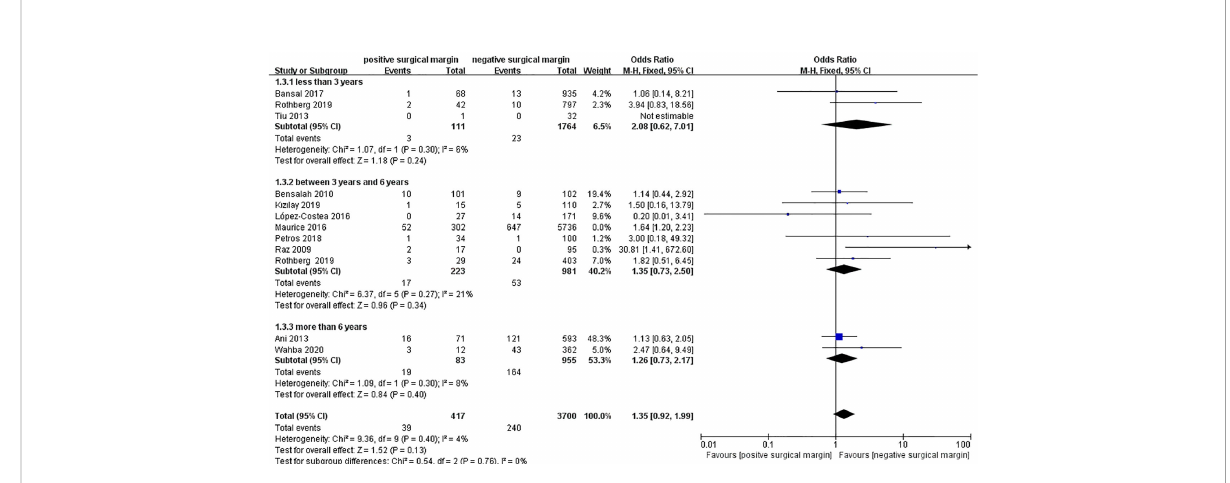
FIGURE 5 Sensitivity analysis of comparison of all-cause death between PSM and NSM groups.